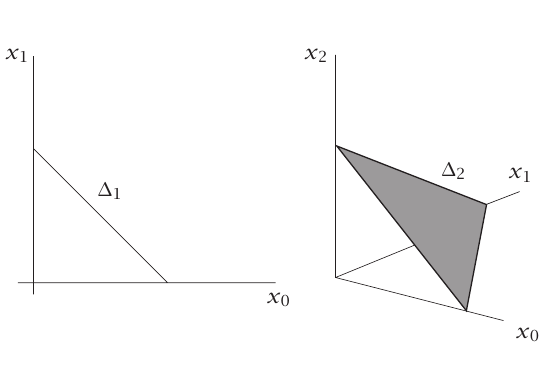
Figure 2.1 . The standard simplexes ∆